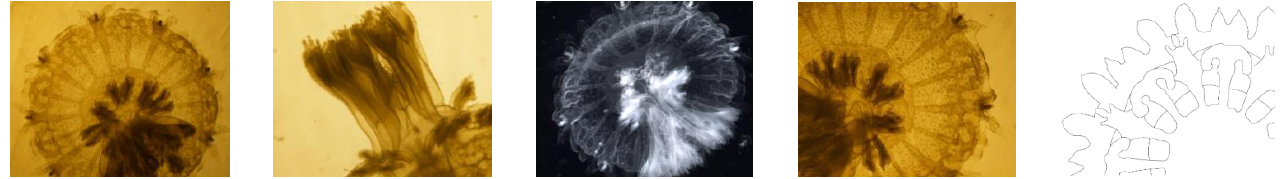
Figure 5. Stage III Ephyrae ( Stomolophus sp. 2). Increased canal system, stomach connected to the margin via radial canals (rhopaliar and velar ones) that are connected to each other by a ring canal; additional radial canals developing centripetally. All marginal lappets becoming rounder and wider. Mouth lips elongating and already branched, with papillae (digitata) at the inner and outer rim.